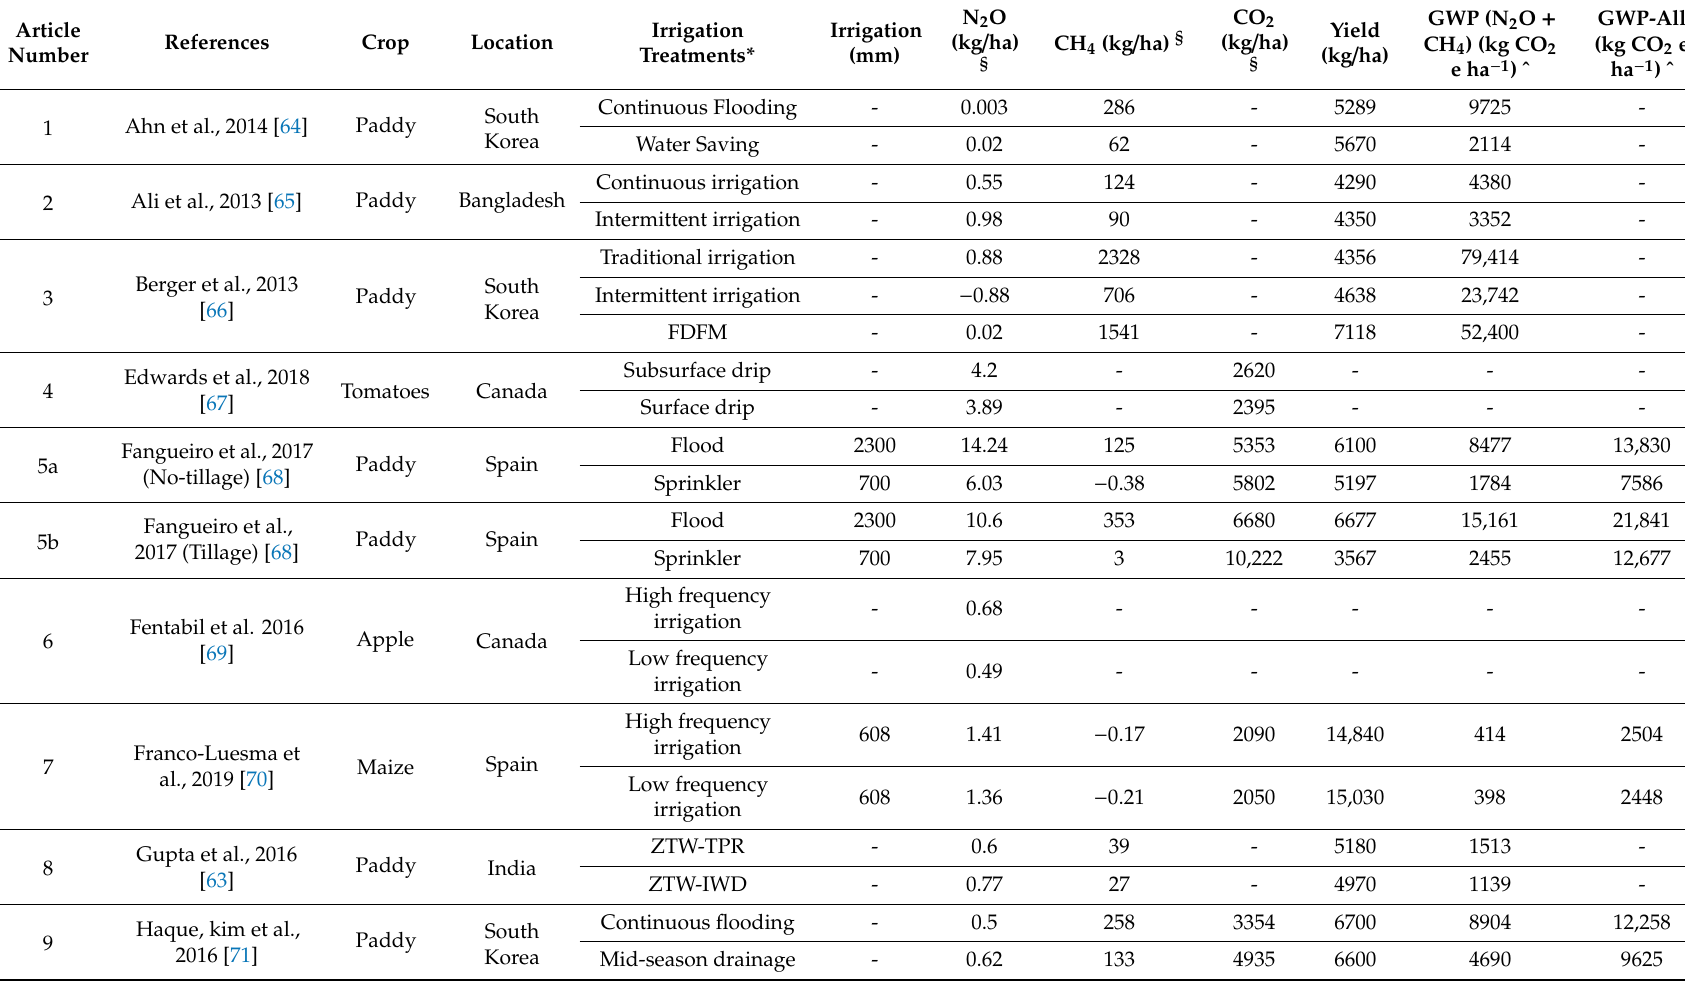
Table 1. Summary of the articles included in the review process. Following the Preferred Reporting Items for Systematic Reviews and Meta-Analyses (PRISMA) guidelines, a total of 32 articles were selected for this study. For any multi-year studies, data presented were averaged, and only the mean values are